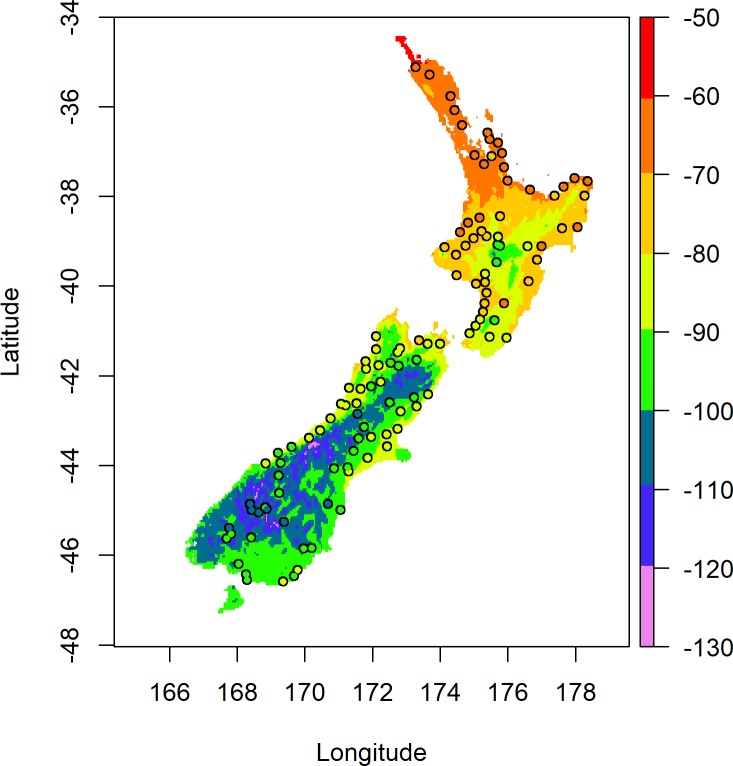
Predicted blackberry leaf δ2H values across New Zealand based on Model 3.Coloured points represent the measured δ2H values for blackberry leaves sampled from those locations.